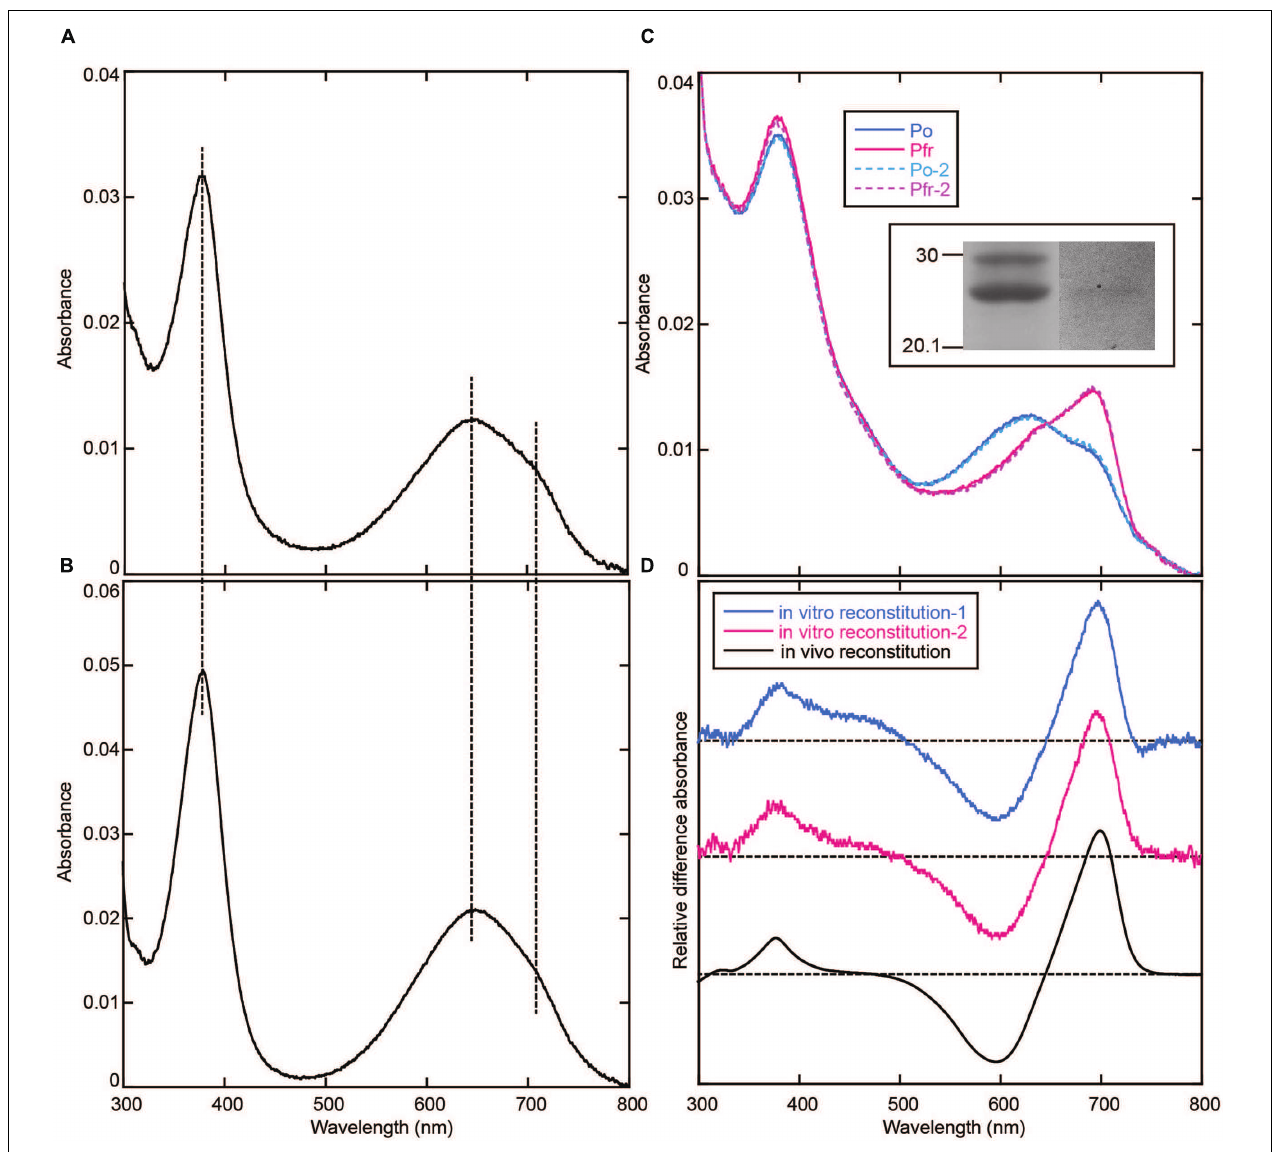
FIGURE 7 | Denaturation with 1% SDS and in vitro reconstitution. (A) Absorption spectrum of AM1_C0023g2-BV Pfr denatured with 1% SDS. (B) Absorption spectrum of AM1_1557g2-BV Pfr denatured with 1% SDS. (C) Absorption spectra of the Pfr and Po forms of S334G reconstituted with BV in vitro . Photoconversion was repeated twice. First-round Po: Solid blue line, first-round Pfr: Solid magenta line, second-round Po: Dotted cyan line, second-round Pfr: Dotted pink line. Inset: SDS-PAGE of in vitro reconstituted S334G. Left, CBB-stained gel. Right, in-gel fluorescence detection. (D) Pfr-minus-Po difference spectra of S334G reconstituted in vitro and in vivo . In vitro reconstitution: blue (first-round) and magenta (second-round) lines, in vivo reconstitution: black